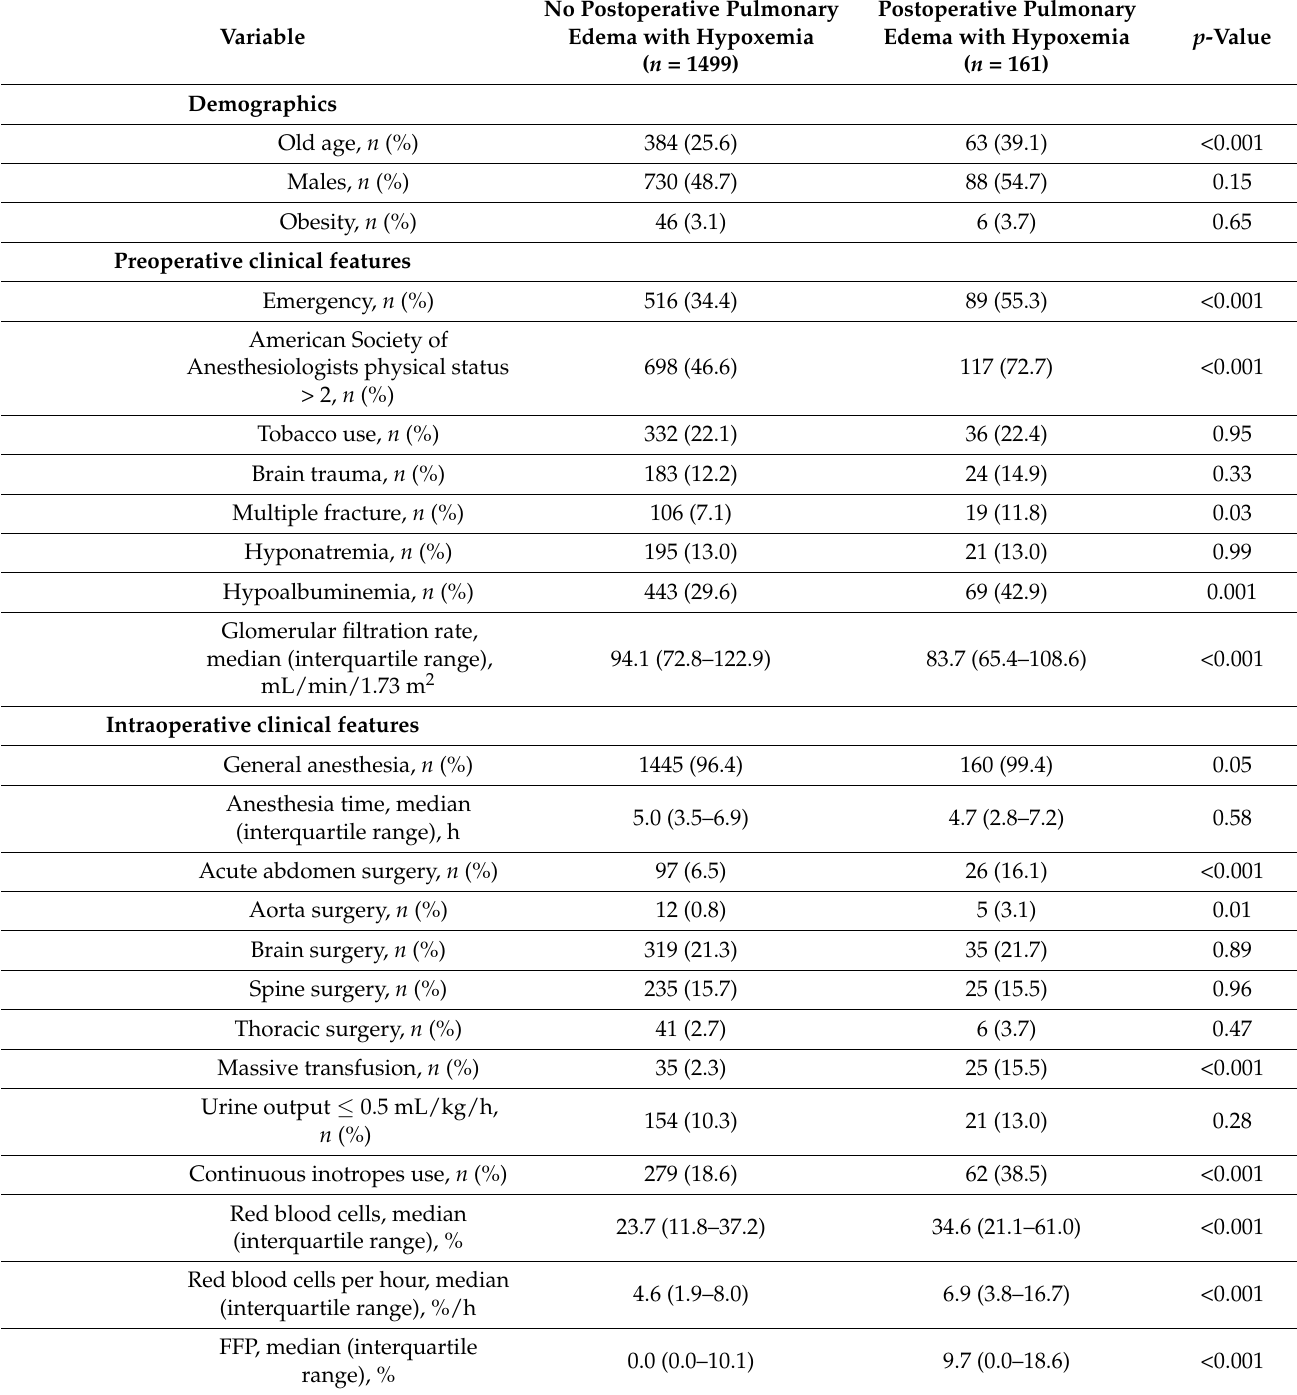
Table 2. Demographic and clinical data of postoperative pulmonary edema patients with